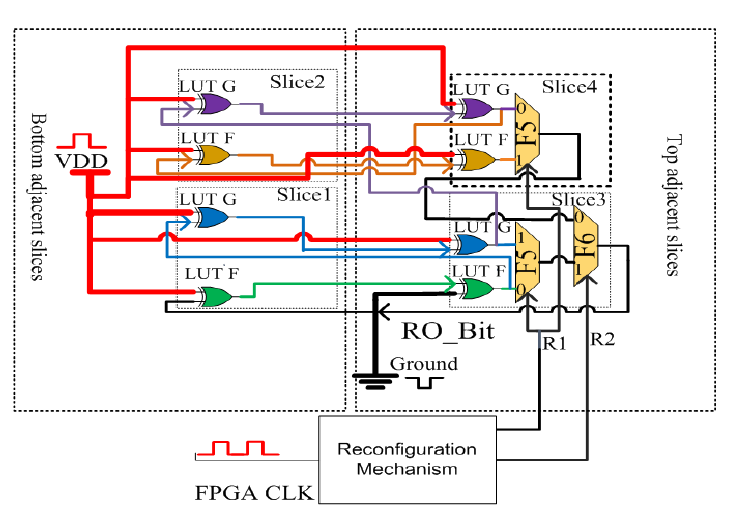
Figure 5. Proposed FPGA-based d-ROPUF scheme of a single